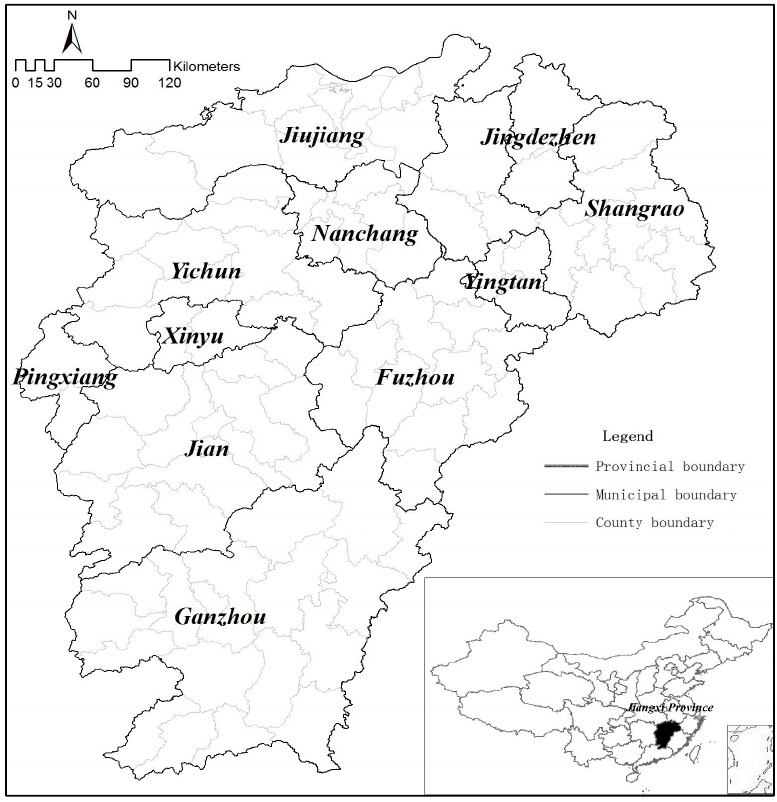
Figure 2. Location of the study region (Jiangxi Province).